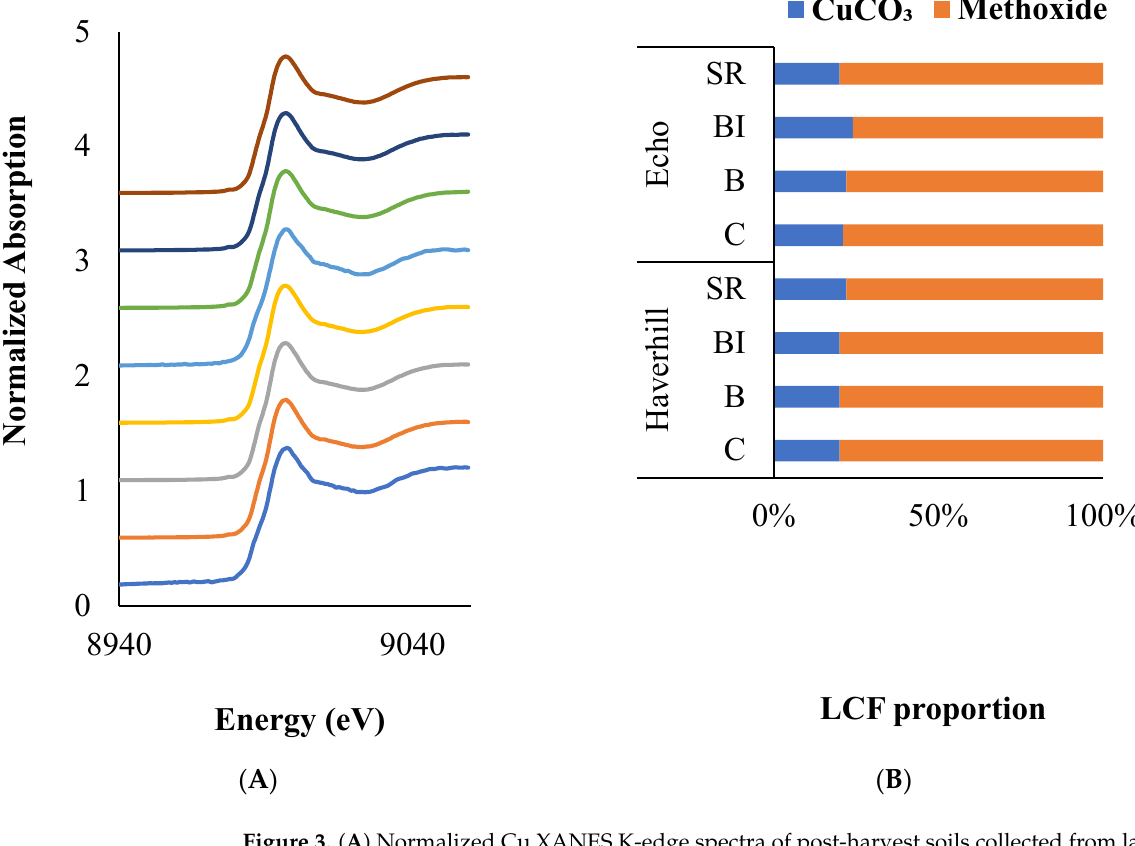
Figure 3. ( A ) Normalized Cu XANES K-edge spectra of post-harvest soils collected from landscape- based Cu fertilization field trials in south-central Saskatchewan conducted on Haverhill (upslope) and Echo (downslope) soil associations in a farm field. ( B ) Results of linear combination fit, showing the relative changes in Cu speciation among treatments. Treatments are C: unfertilized control; B: broadcast; Cu BI: broadcast and incorporation Cu; and SR: seed row banding of sulfate form of Cu fertilizer at the rate of 2 kg ha − 1